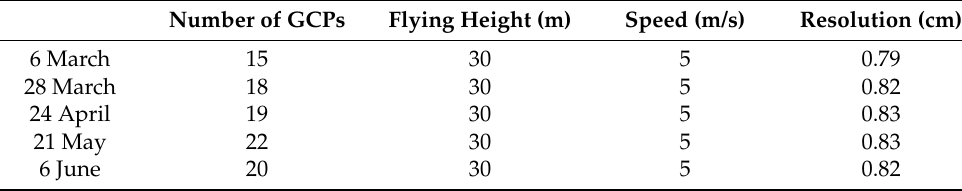
Table 2. UAV data (orthomosaic and digital surface model) information. Number of GCPs Flying Height (m) Speed (m/s) Resolution